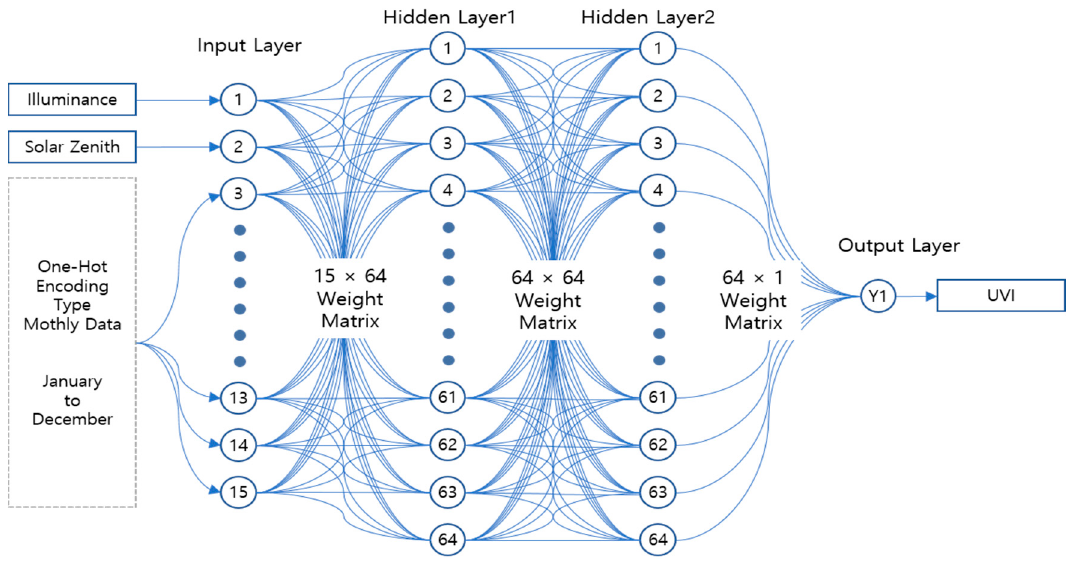
Figure 6. DNN model for the illumination-based UVI calculation.